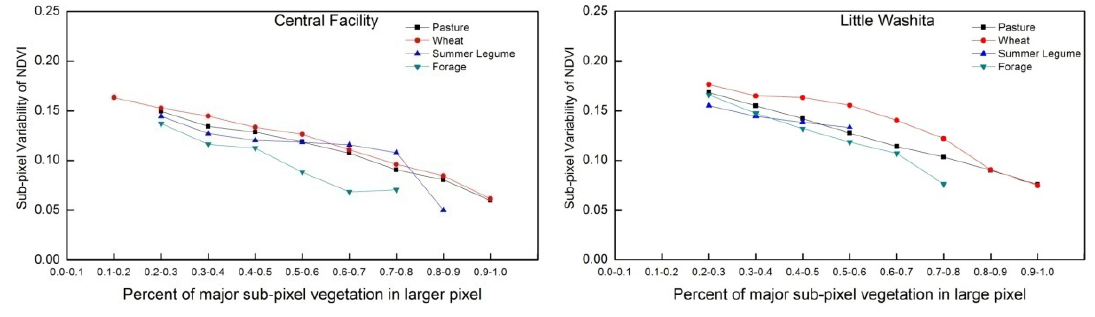
Figure 4. Sub-pixel variability of NDVI within the ESTAR footprint as measured by the standard deviation for different land-cover data at 30m resolution from Central Facility and Little